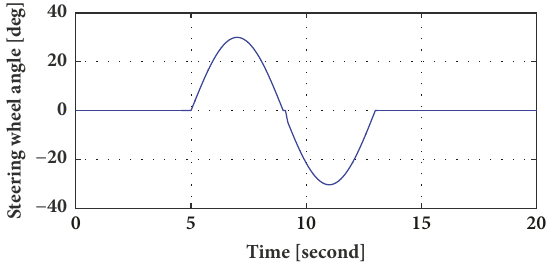
Figure 7: Steering wheel